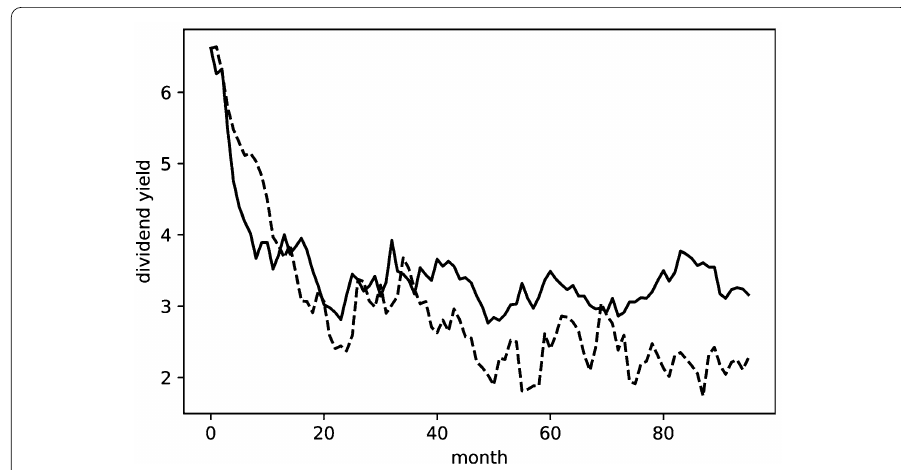
Figure 2 Sample of SDY model simulated path (dashed line) compared to actual data (normal line)